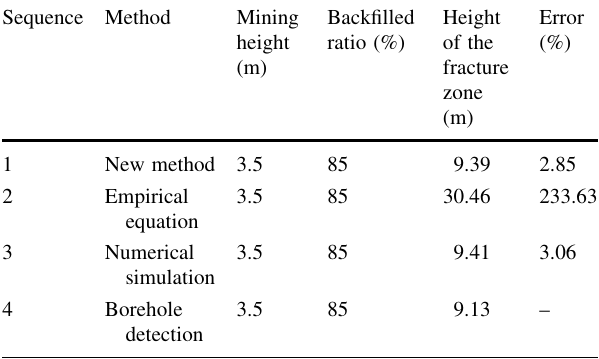
Table 4 Comparison of the fracture zone heights obtained using different